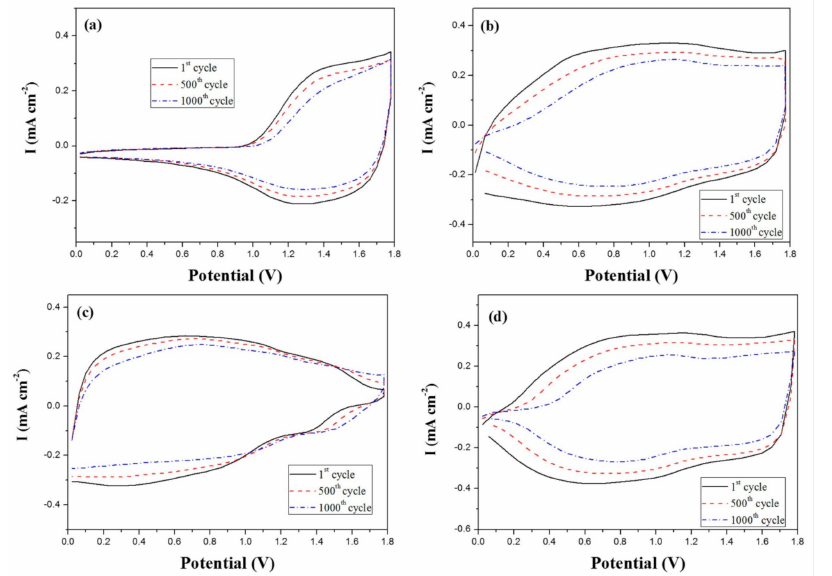
Figure 13. Cyclic voltammograms of ( a ) PBPBC/PEDOT, ( b ) P(BPBC- co -BT)/PEDOT, ( c ) P(BPBC- co